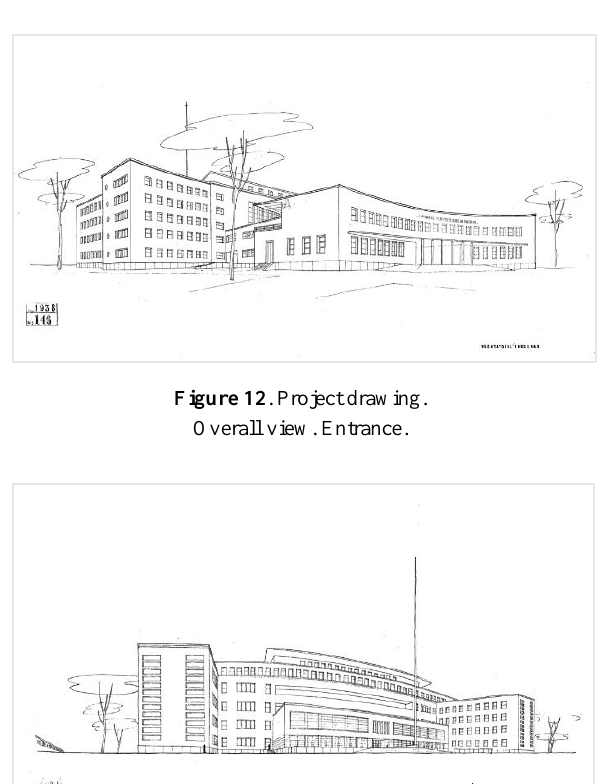
Figure 11 . Project drawing. Right-side elevation.